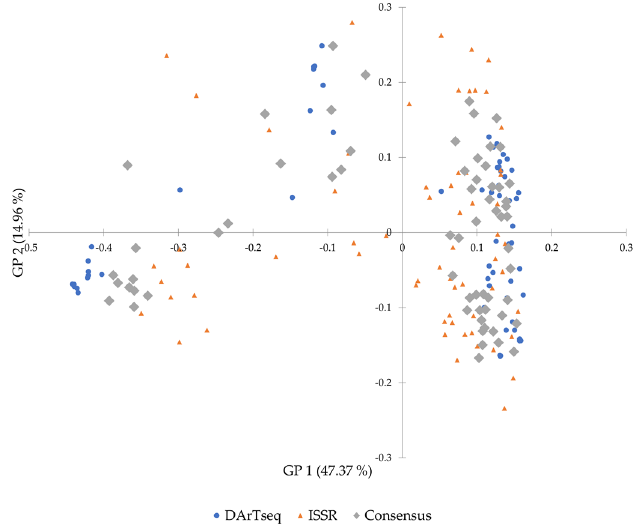
Figure 9. Generalized Procrustes Analysis (GPA) of 116 spring barley cultivars landraces based on ISSR and DArTseq data.